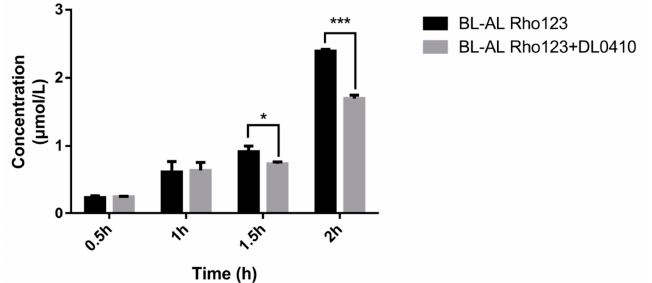
Figure 4. The effects of DL0410 on the transport of Rho123 in MDCK-MDR1 cells. Transport of Rho123 (10 µM) was measured for 2 h in monolayer cultures of MDCK-MDR1 in the absence or presence of DL0410 (50 µM). (Mean ± SD, n = 3). The criterion of significance was set at p < 0.05 (* p < 0.05, *** p < 0.001).